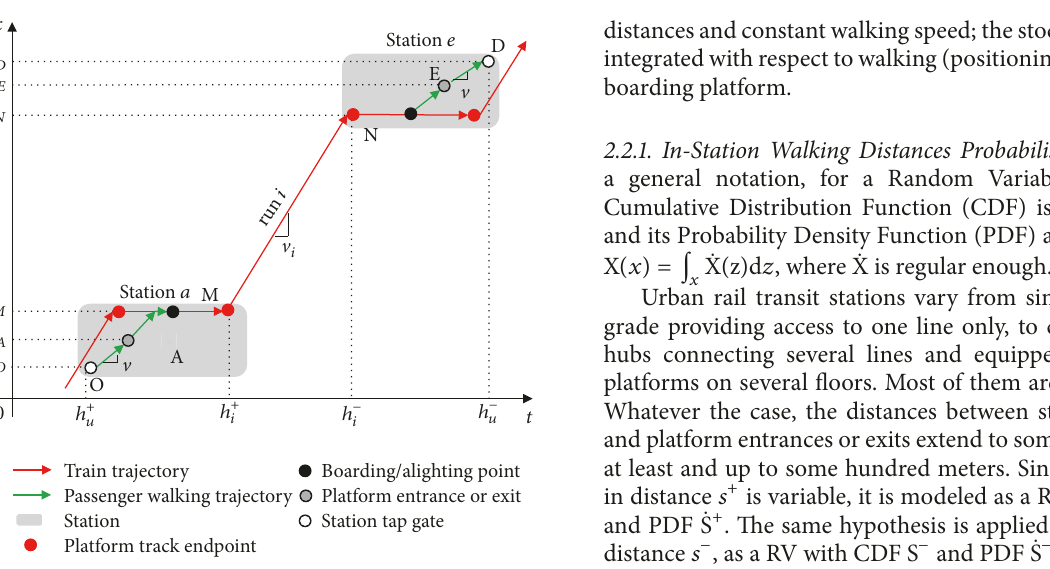
Figure 1: Time-space diagram: train and passenger trajectories. is equal to ℎ − 𝑖 − ℎ + 𝑖 . Train travel time is considered as in- vehicle travel time for all passengers who take the same train. The frequency of each service is heterogeneous: Peak Hour (PH) is different from Off-Peak Hour (OPH). Trains along passengers’ travel direction consist in a set 𝐼 for all train runs = 𝑡 − 𝑡 𝑖 during the studied period 𝑡 𝑝 2 1 . The traffic conditions and line service quality (punctuality, regularity, etc.) depend on passengers’ conditions in all served